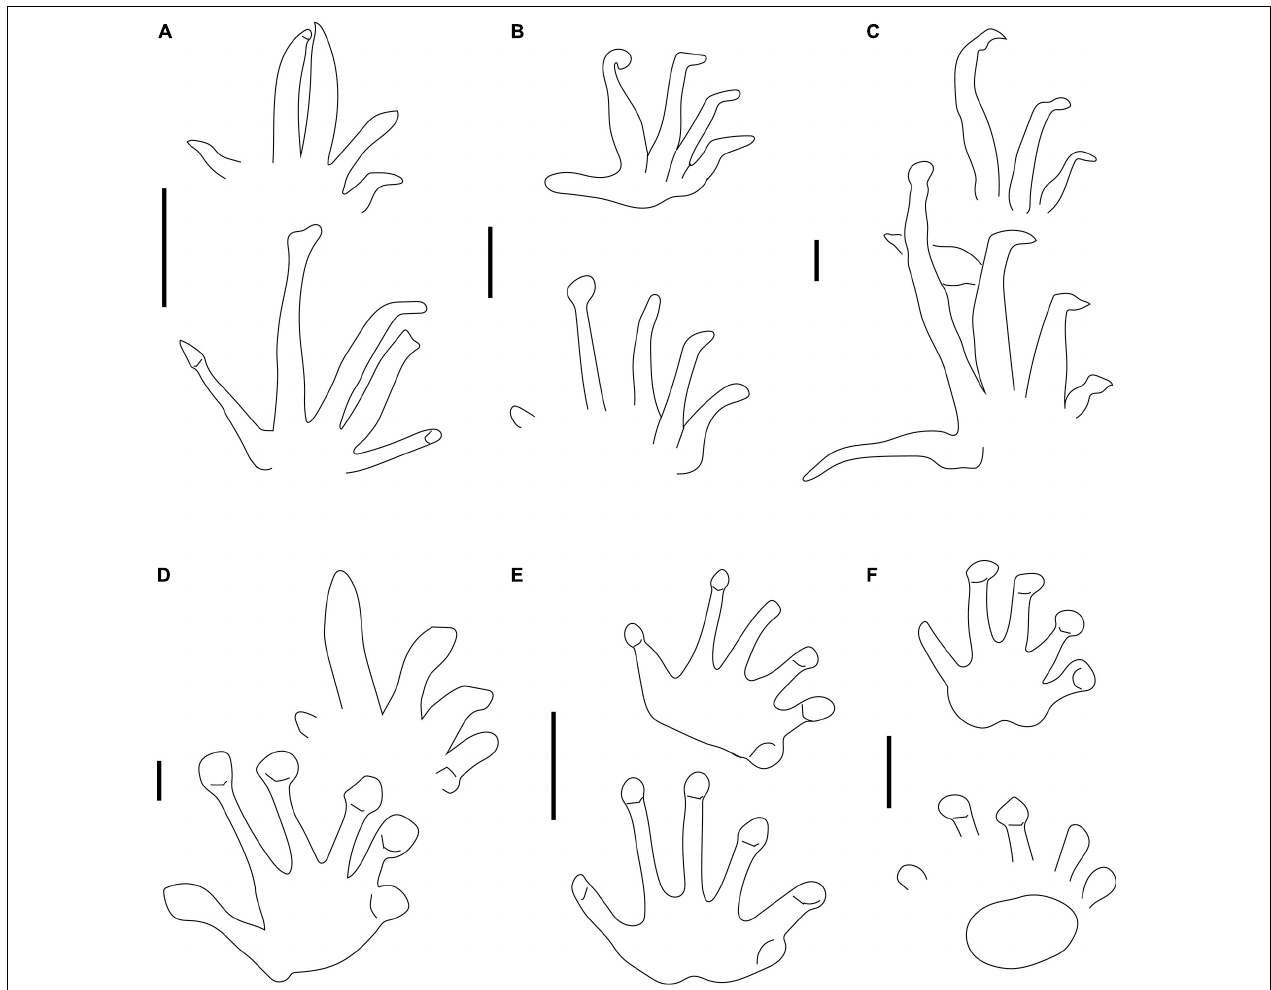
FIGURE 2 | Carboniferous ichnotaxa attributed to reptiles (A–C) and anamniote reptiliomorphs (D–F) , interpretive drawings. (A–F) See caption of Figure 1 . Scale bars (A–E) are 1 cm, scale bar (F) is 5